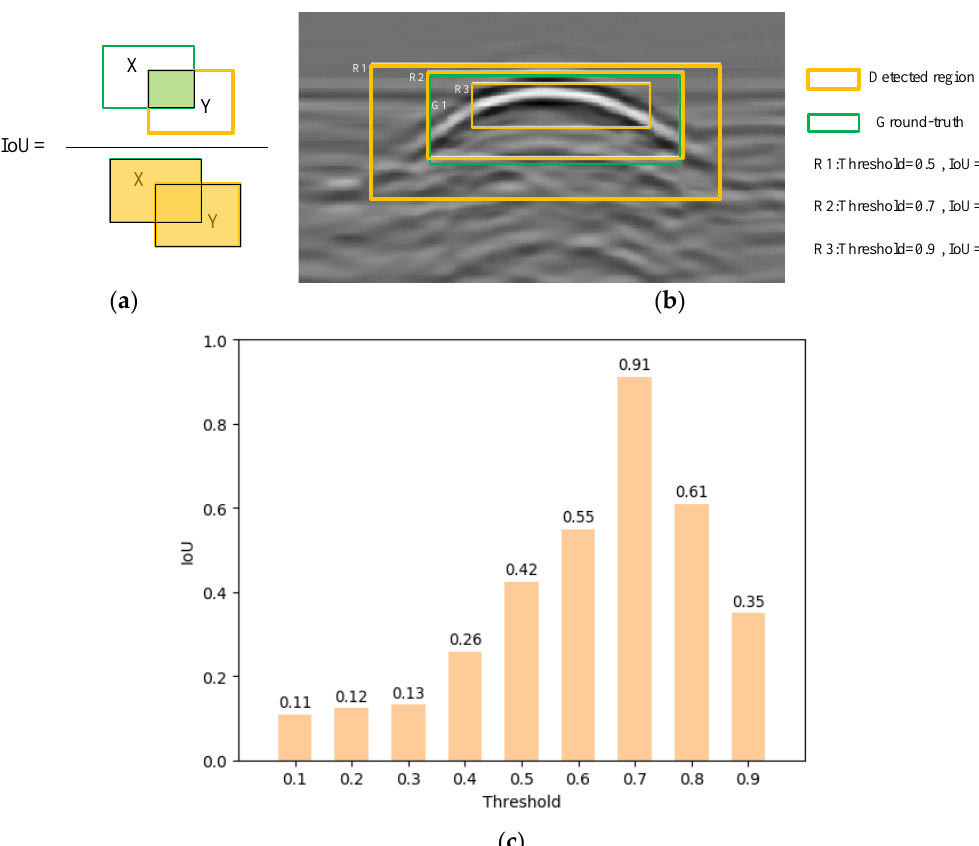
Figure 5. Threshold selection. ( a ) IoU calculation, ( b ) hyperbola region detection results under di ff erent thresholds, ( c ) IoU value under di ff erent thresholds.